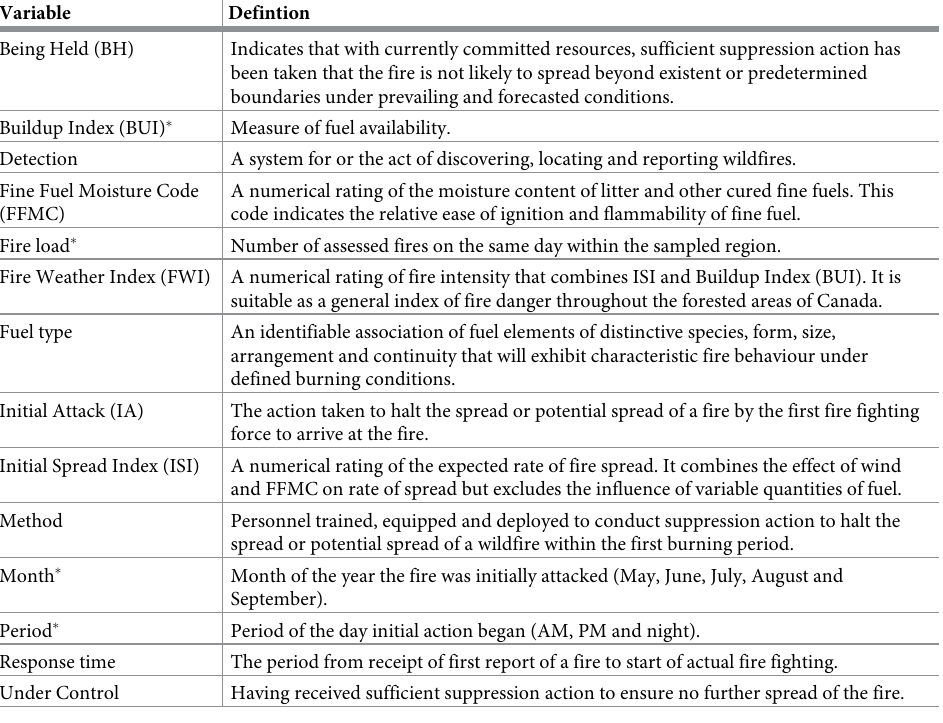
Table 1. Definition of each variable considered for inclusion in